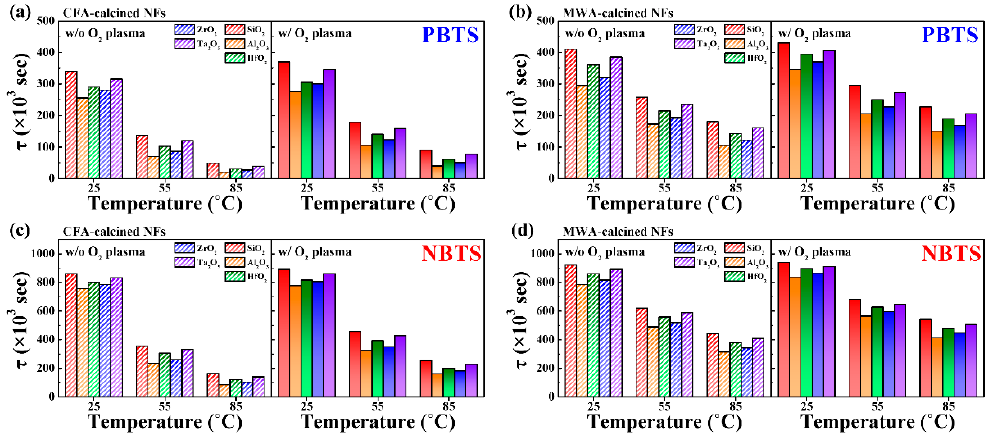
Figure 10. Charge trapping time ( τ ) values of IGZO NF FETs based on different high- k dielectrics as determined from PBTS and NBTS tests. ( a ) CFA-calcined and ( b ) MWA-calcined devices during PBTS test. ( c ) CFA-calcined and ( d ) MWA-calcined devices during NBTS test. Dashed and solid bars indicate data for FETs obtained before and after postcalcination oxygen plasma treatment, respectively.